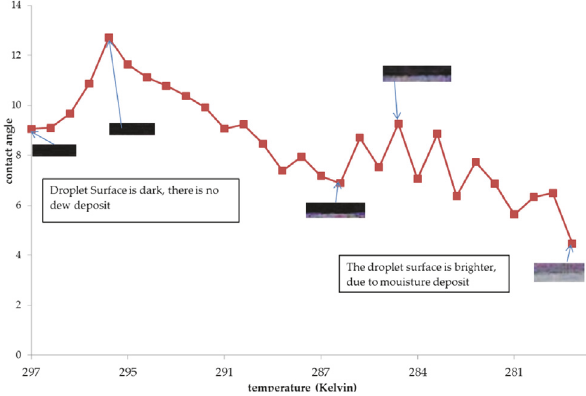
Figure 5: Coconut oil contact angle vs. temperature.